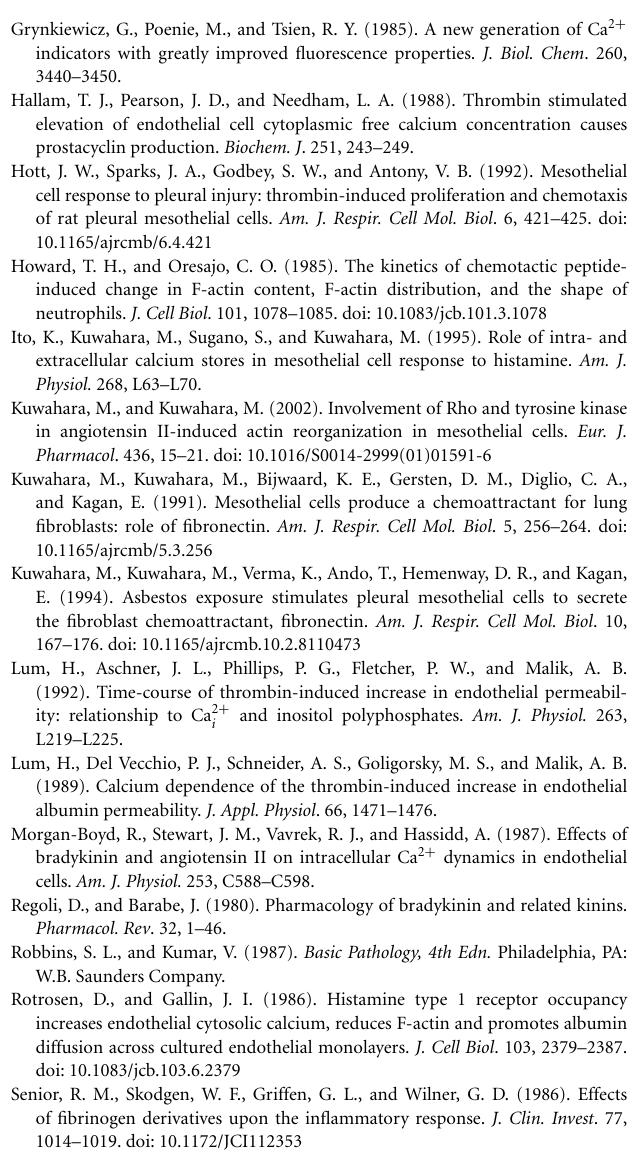
FIGURE 4 | (A) Time course of changes and (B) effects of Ca 2 + chelation by BAPTA (5mM) and stabilization of the actin cytoskeleton by cytochalasin B (10 μ g/ml) on histamine (1mM), bradykinin (10 μ M),